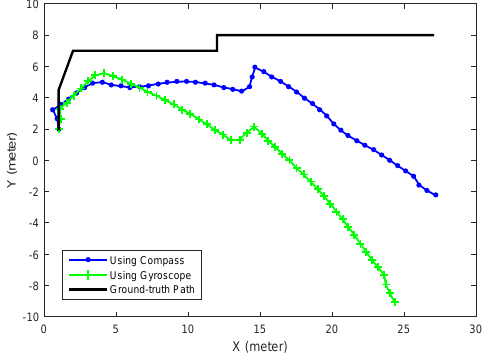
Figure 7: The accumulated error of the DR method Next, we compare the localization accuracy of the proposed method with that of the commonly-used landmarks+DR methods. Fig- ure 8 shows the results of different localization methods, from which we can see that the proposed method outperforms the other two methods. Specifically, our method can achieve 73% accuracy with the error less than 2.5 meters, compared to 45% for the other two methods. When the accuracy reaches up to 100%, the cor- responding error for our method is less than 3.5 meters, but